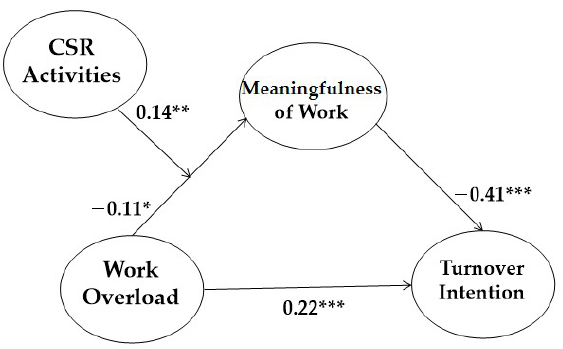
Figure 2. The Result of Coefficient Values of our Research Model.